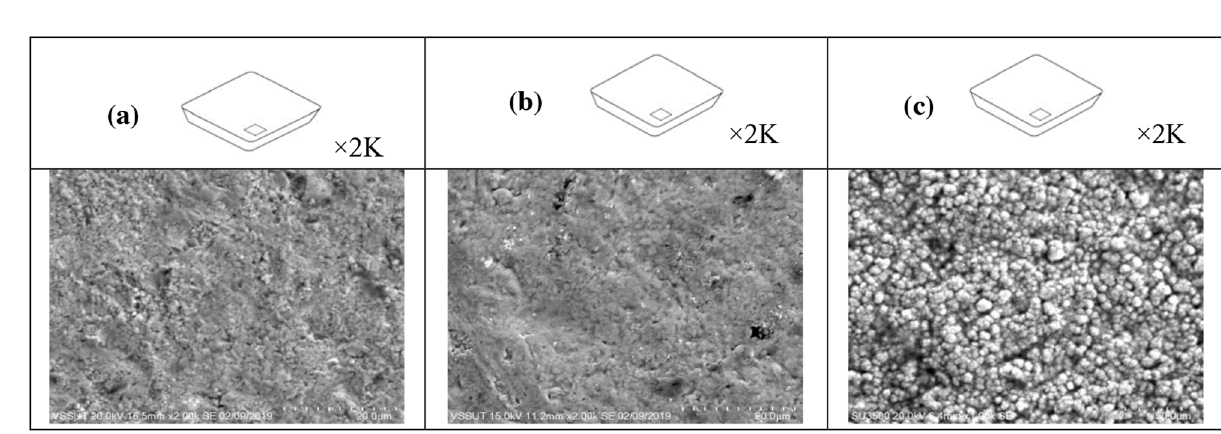
Fig. 1. SEM surface morphology of (a) after pretreatment, (b) after seeding and (c) showing the nucleation of